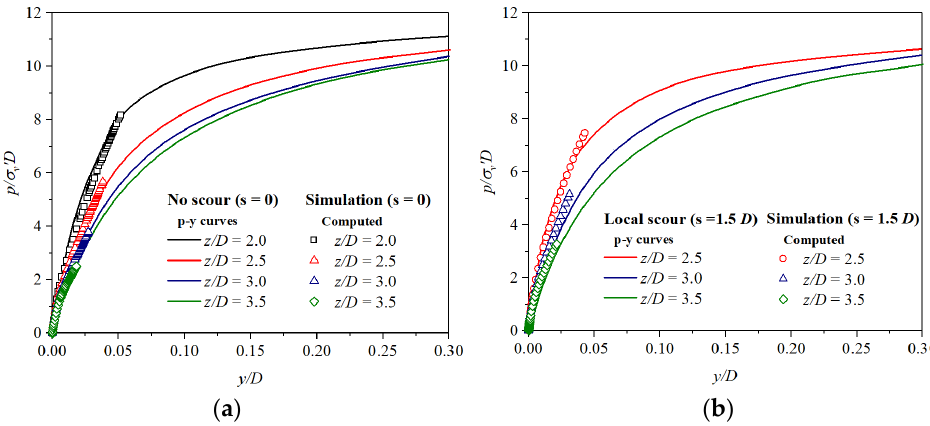
Figure 15. The p-y curves consider the dilatancy in ( a ) no scour condition; ( b ) local scour condi-